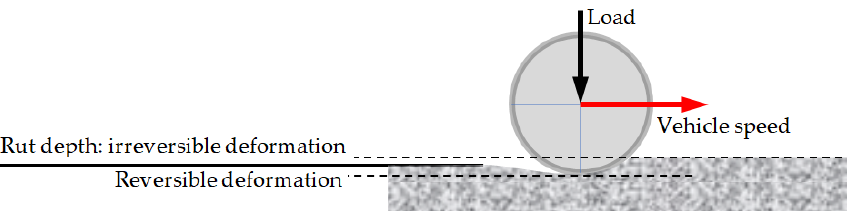
Figure 2. Deflection of the road surface and rut forming under the action of a moving load. Total deformation = reversible deformation + irreversible deformation (rut depth).